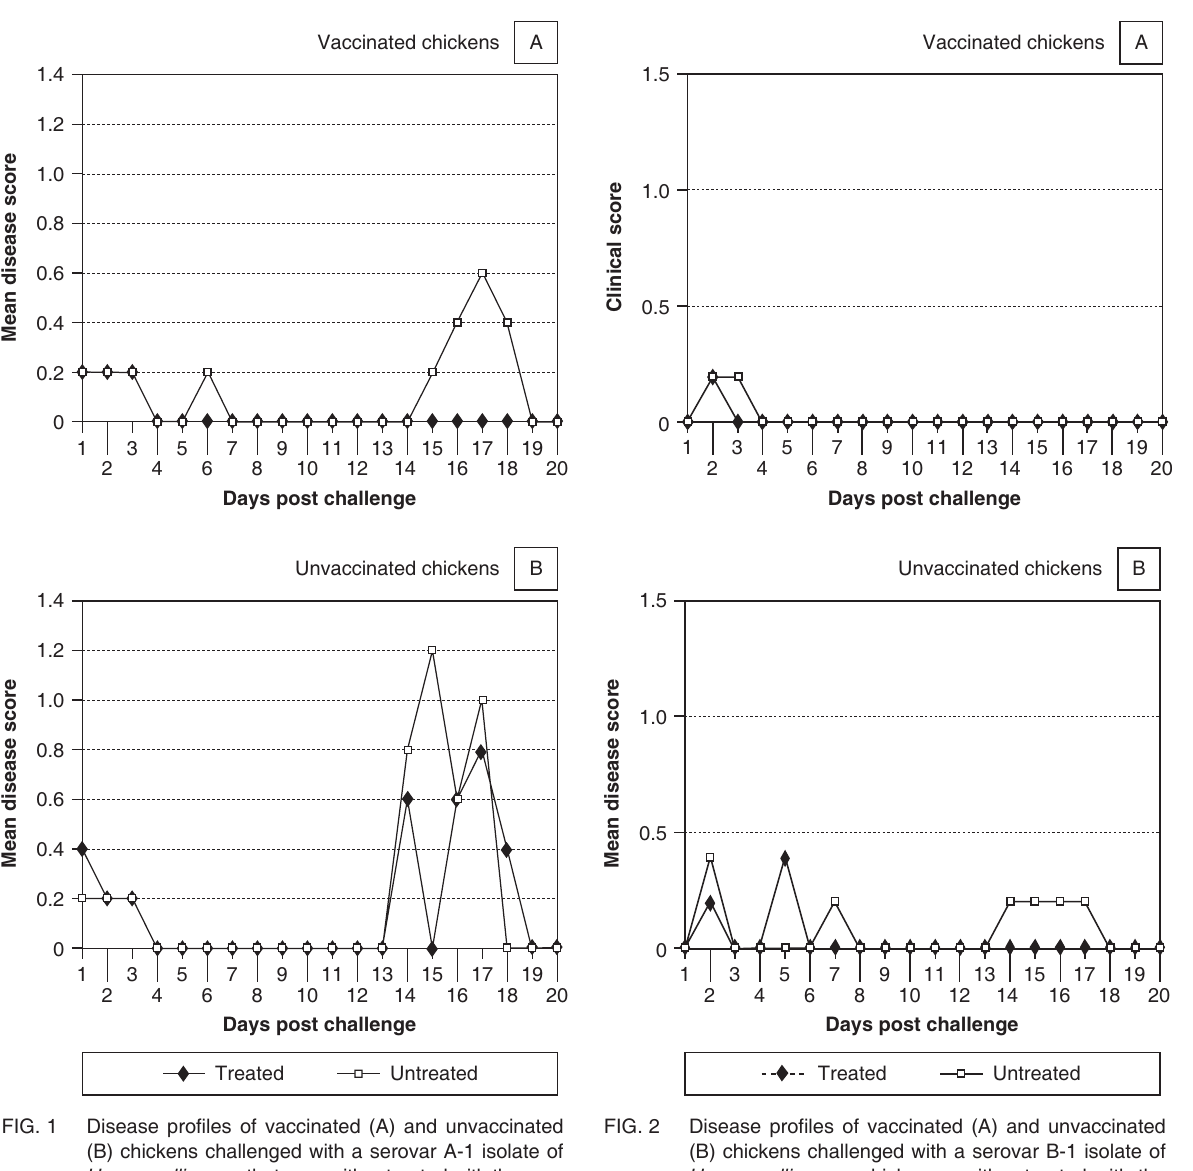
FIG. 1 Disease profiles of vaccinated (A) and unvaccinated (B) chickens challenged with a serovar A-1 isolate of H. paragallinarum that were either treated with the con- tinuous disinfection programme (treated) using Virukill or not treated (untreated) in any other way